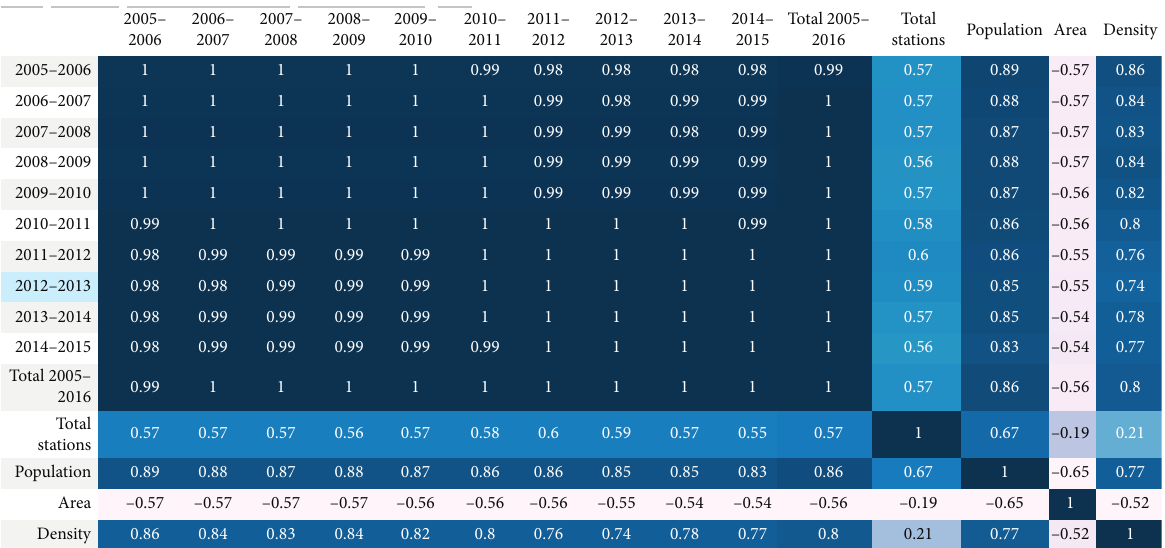
Figure 9: Correlation